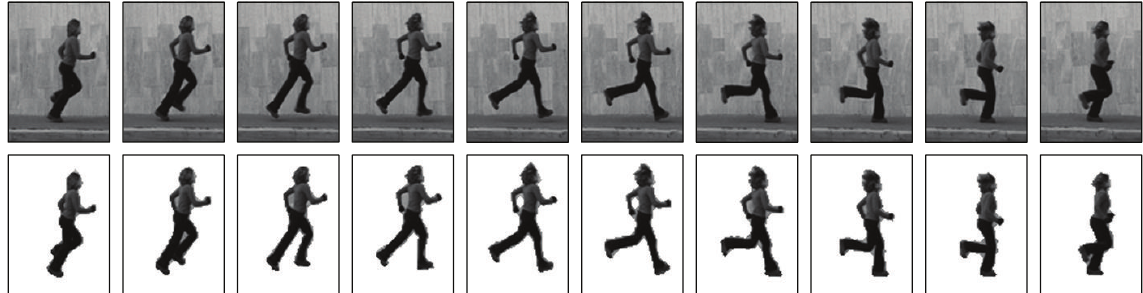
Figure 2: First row shows original video sequence for testing data (Lena run1 from Weizmann dataset), and second row is background subtracted video sequence to calculate optical flow for training